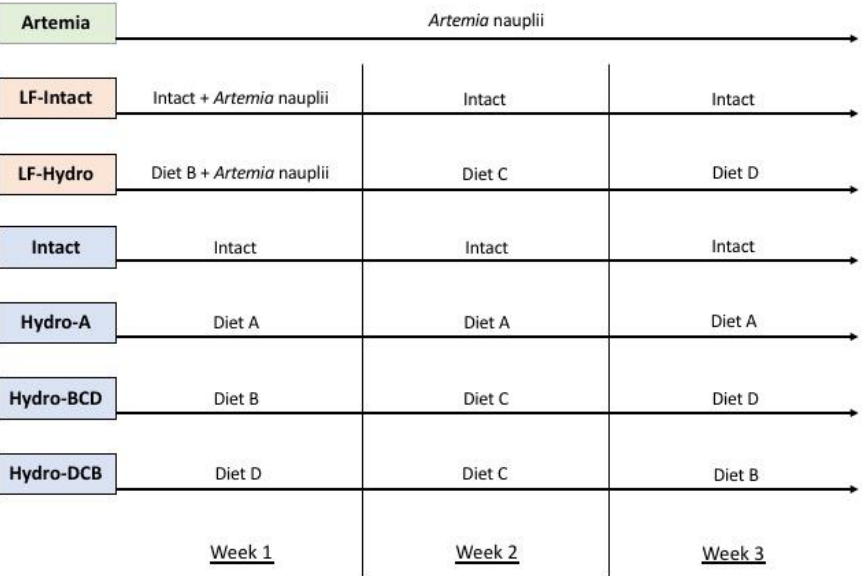
Figure 1. Feeding regimens for experimental groups. Groups in green were fed with live feed, groups in orange were co-fed, and groups in blue were fed dry diets only. All diets were fed in excess during each feeding. The LF-Intact and LF-Hydro groups were fed decreasing amounts of Artemia starting on day 3 to wean them completely onto dry feed starting with week 2. The switch in diets commenced immediately after the sampling and measuring conducted at the end of each